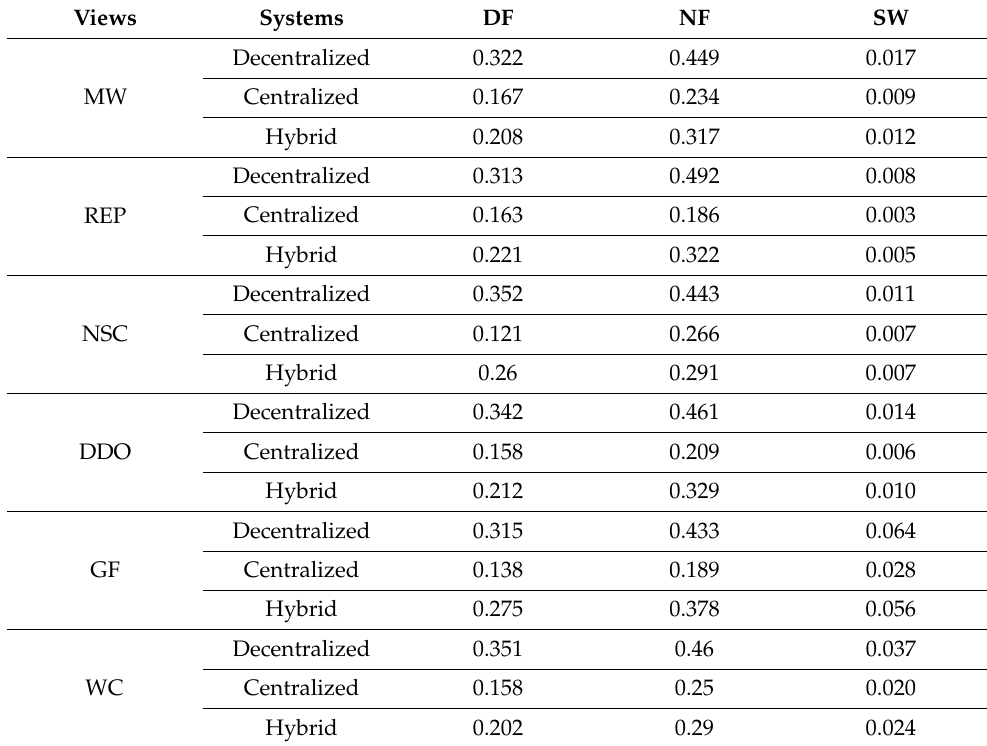
Table 13. The results of defuzzification, normalization and synthesis weights in cryptocurrency trading systems.